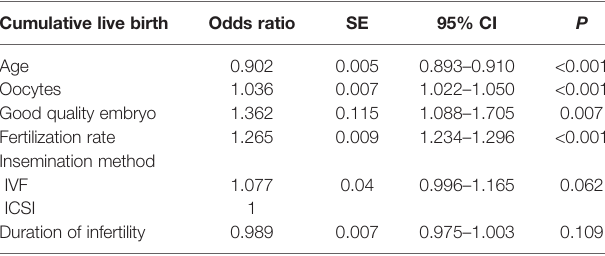
TABLE 2 | Logistic regression analysis with odds ratios for CLBR. Cumulative live